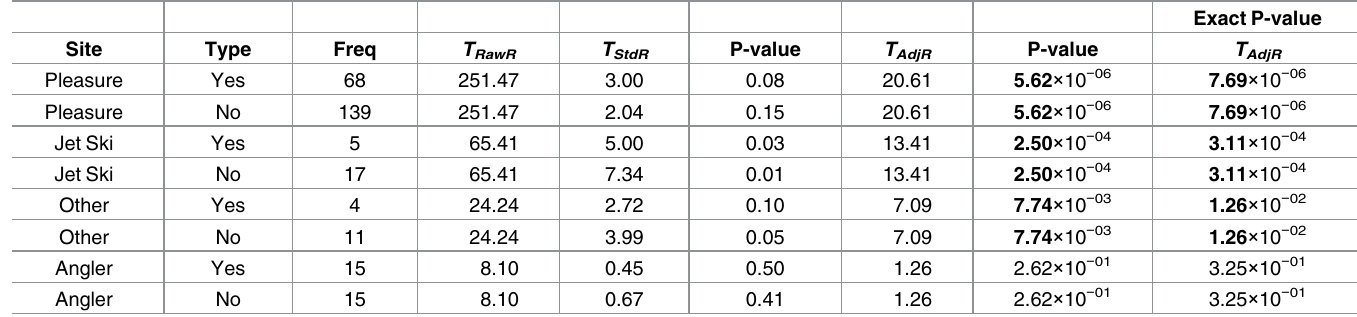
Table 5. P-value calculation for each cell of data from the survey for the awareness of zebra mussels. The calculatedp-value for each cell is compared to the multiplecomparisoncorrection method by Simes [18]. The cells with significantp-values are bold.